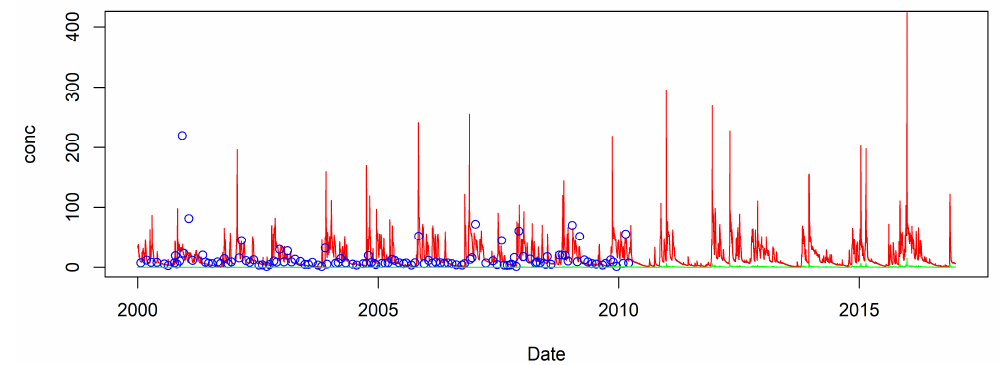
Figure 8. Time series plot of baseline (red) and the difference between baseline and post-intervention (green) in prediction of suspended solids (ug/L) from 2000 to 2016. Maximum diffuse concentration improvement was 14.11 ug/L. Monitoring data is represented by blue circles.